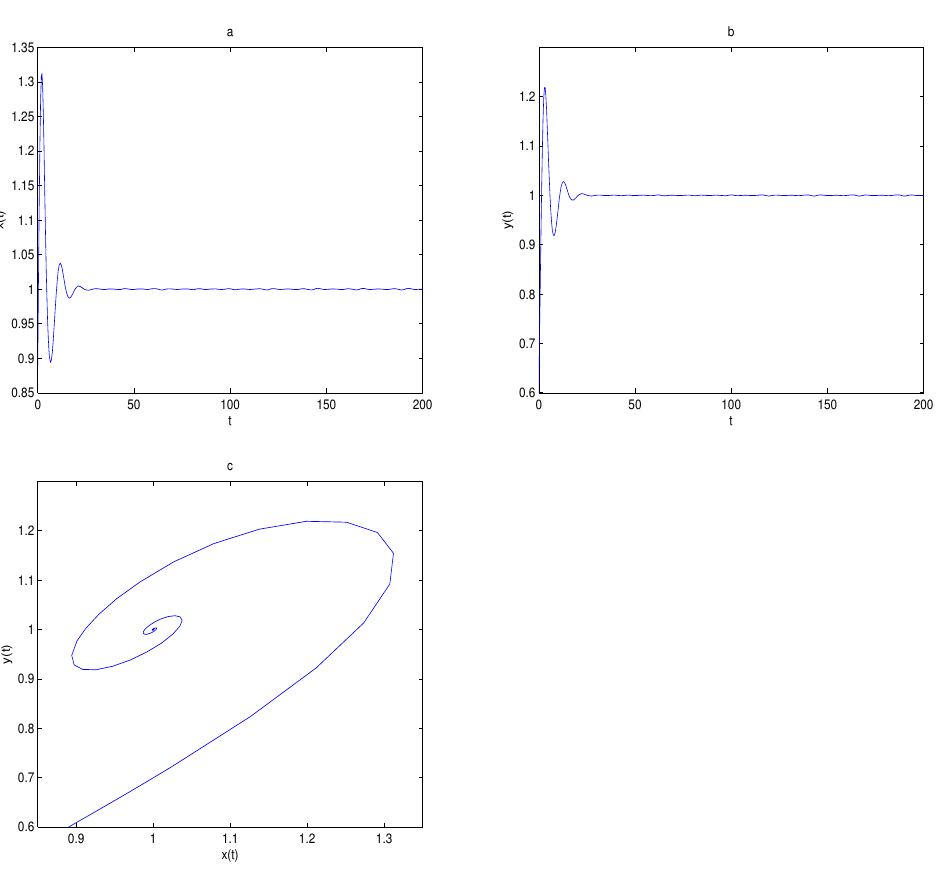
Figure 16. O is a saddle node. A 5 ( 1,1 ) is locally stable. In here r = 2, ω = 1, b = 1, c = 2, α = 0.93. Subfigure ( a ) is time series of x ( t ) , subfigure ( b ) is time series of y ( t ) , and subfigure ( c ) is a phase diagram of system